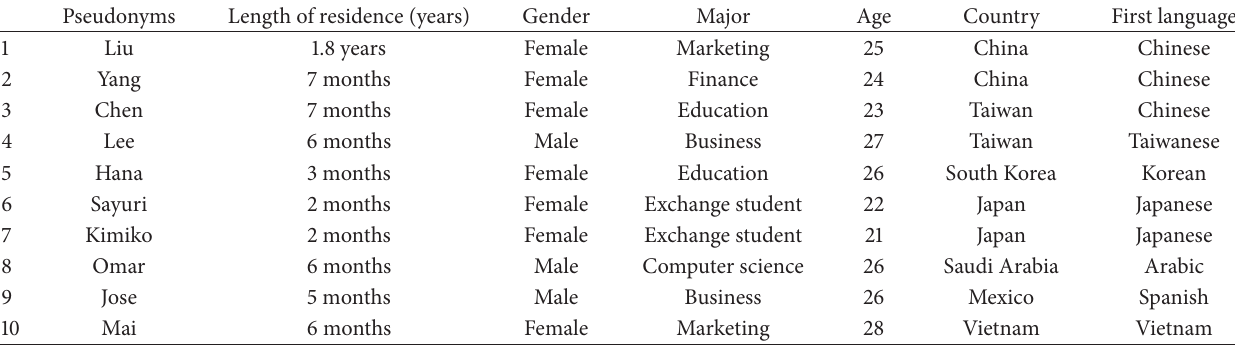
Table 2: Demographics of the